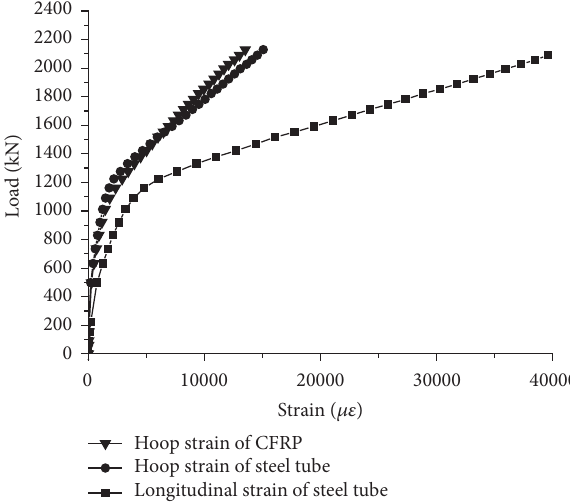
Figure 6: Load-strain curves of